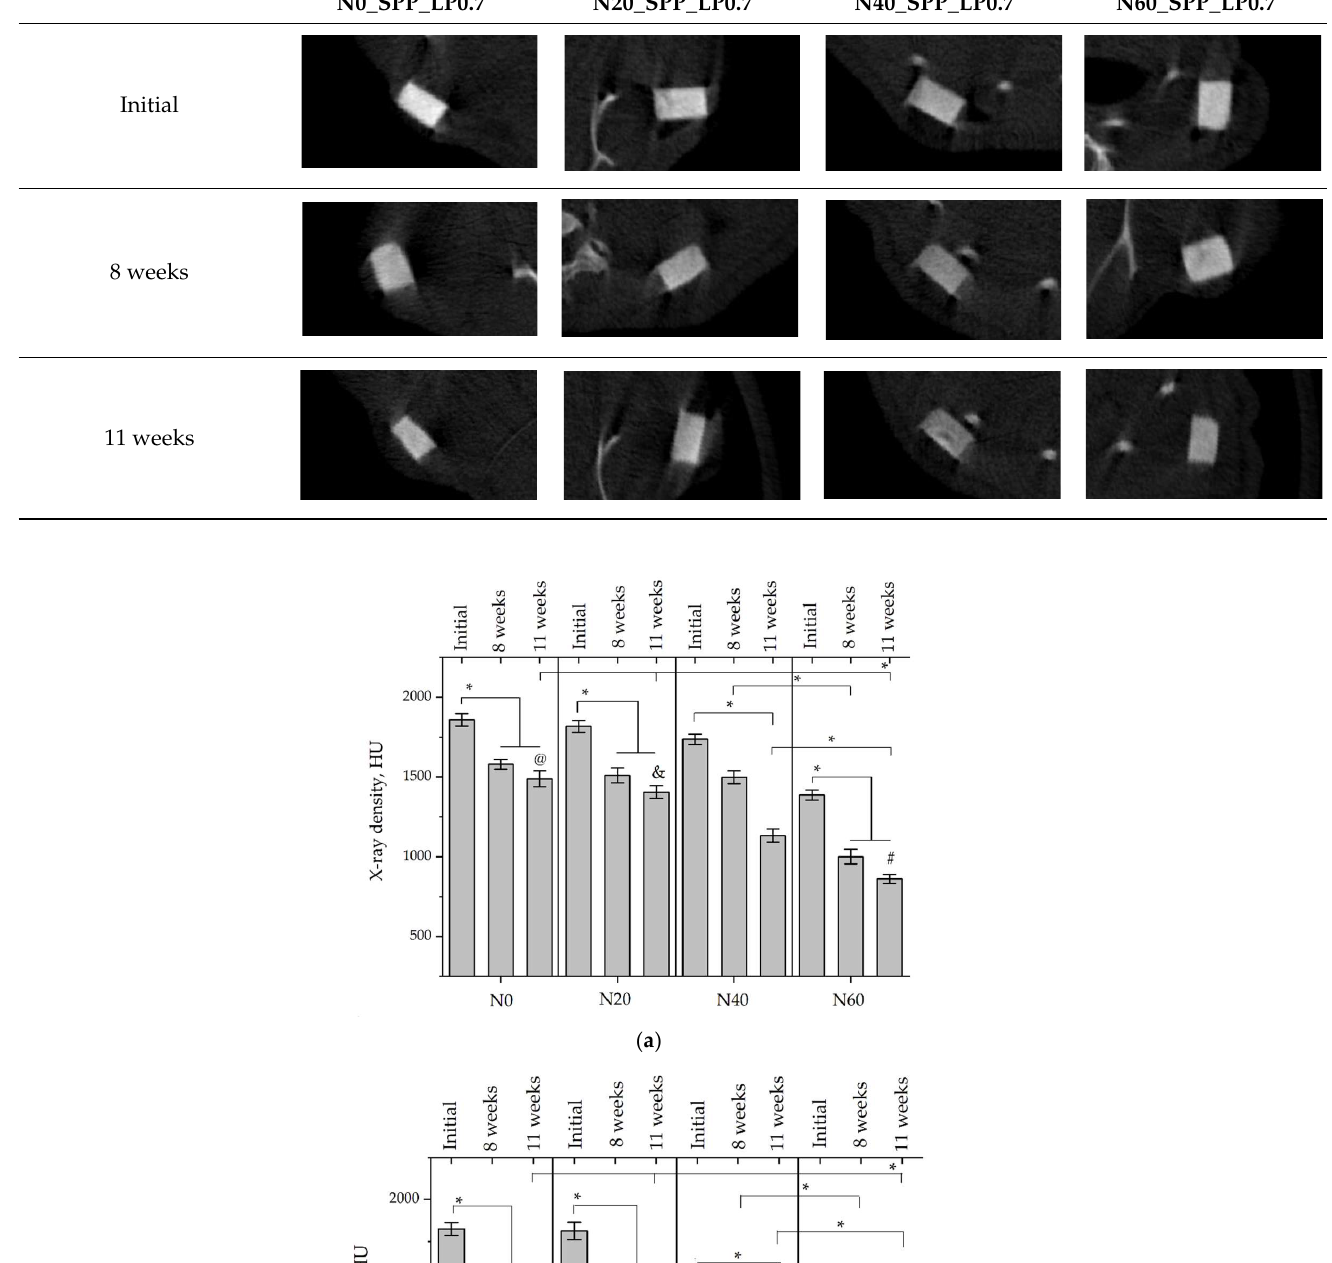
Table 5. Examples of X-ray micrographs for ceramics with SPP and X-ray density (HU) of the implants immediately after implantation (initial), after 8 weeks, and after 11 weeks in situ.